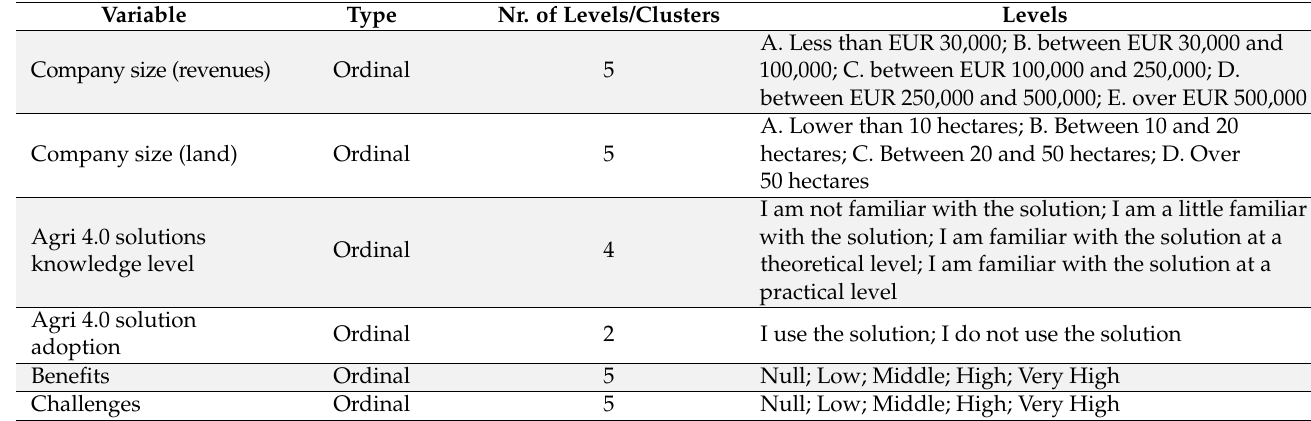
Table 7. Variable definition and